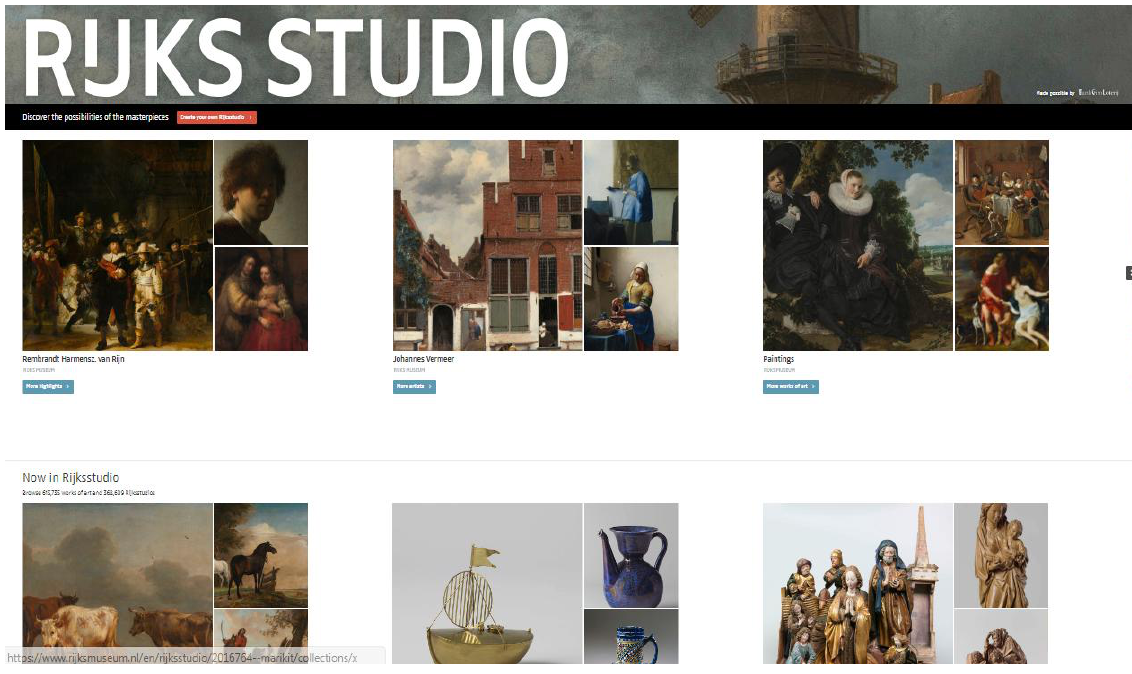
Figure 4. Rijksstudio, Rijksmuseum of Amsterdam,